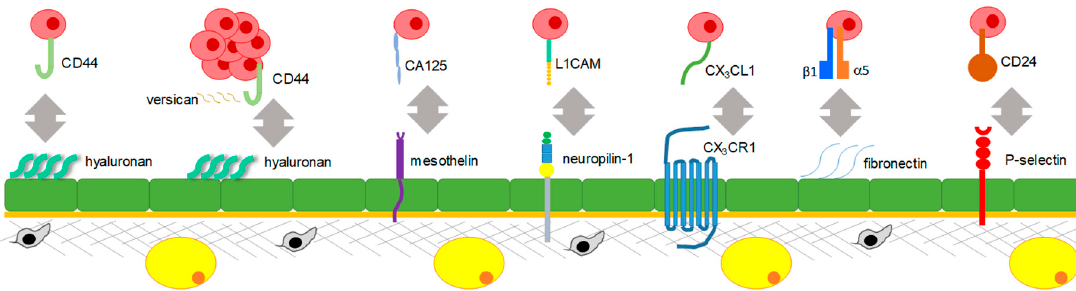
Figure 2. Molecular mechanisms regulating peritoneal adhesion. Disseminating epithelial ovarian cancer cells and spheroids are shown in mauve, mesothelial cells are shown in green, the basement membrane is shown in orange, stromal cells are shown in grey, parenchymal cells are shown in yellow, and the extracellular matrix is shown in grey. Only one interaction between a cancer cell and a mesothelial cell is shown for simplicity and a clearer presentation of the known mechanisms. CD44: CD44 molecule; CA125: mucin 16, cell surface associated or ovarian carcinoma antigen CA125; L1CAM: L1 cell adhesion molecule; CX 3 CL1: C-X3-C motif chemokine ligand 1; CX 3 CR1: C-X3-C motif chemokine receptor 1; CD24: CD24 molecule.